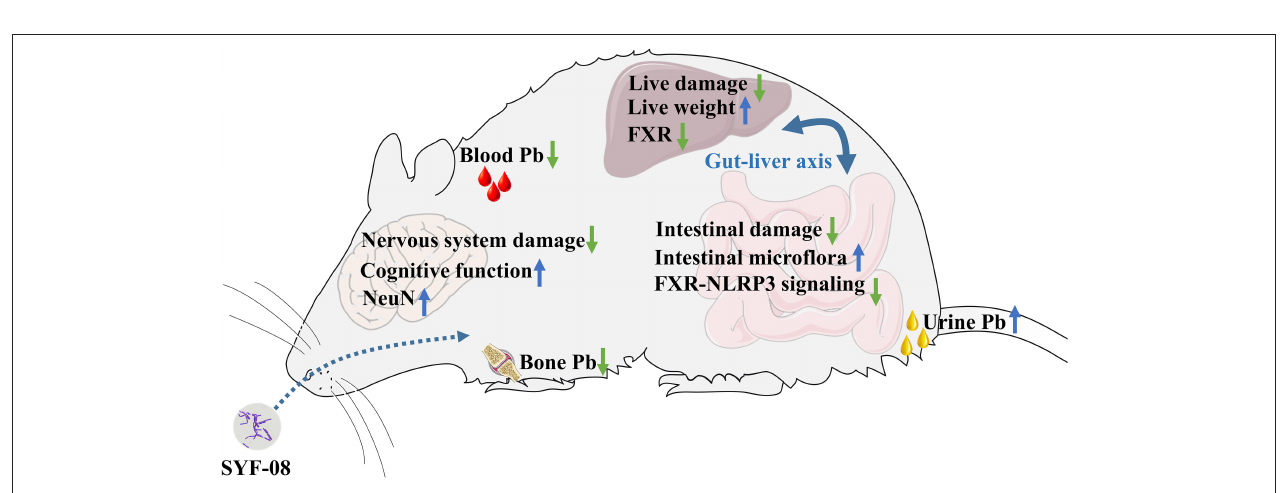
FIGURE 7 | Lactobacillus casei SYF-08 inhibits the activated FXR-NLRP3 signaling pathway in the gut. (A) The transcript level of FXR in the different groups. (B) The protein level of FXR and FGF15 in the different groups. (C) Relative gray level of FXR. (D) Relative gray level of FGF-15. (E) The mRNA level of NLRP3 in different groups. (F) The mRNA level of IL-1 β in different groups. (G) The protein level of NLRP3, Caspase 1 and IL-1 β in the different groups. (H) Relative gray level of Caspase 1-p20. (I) Relative gray level of NLRP3. (J) Relative gray level of activated IL-1 β . ** P < 0.01.